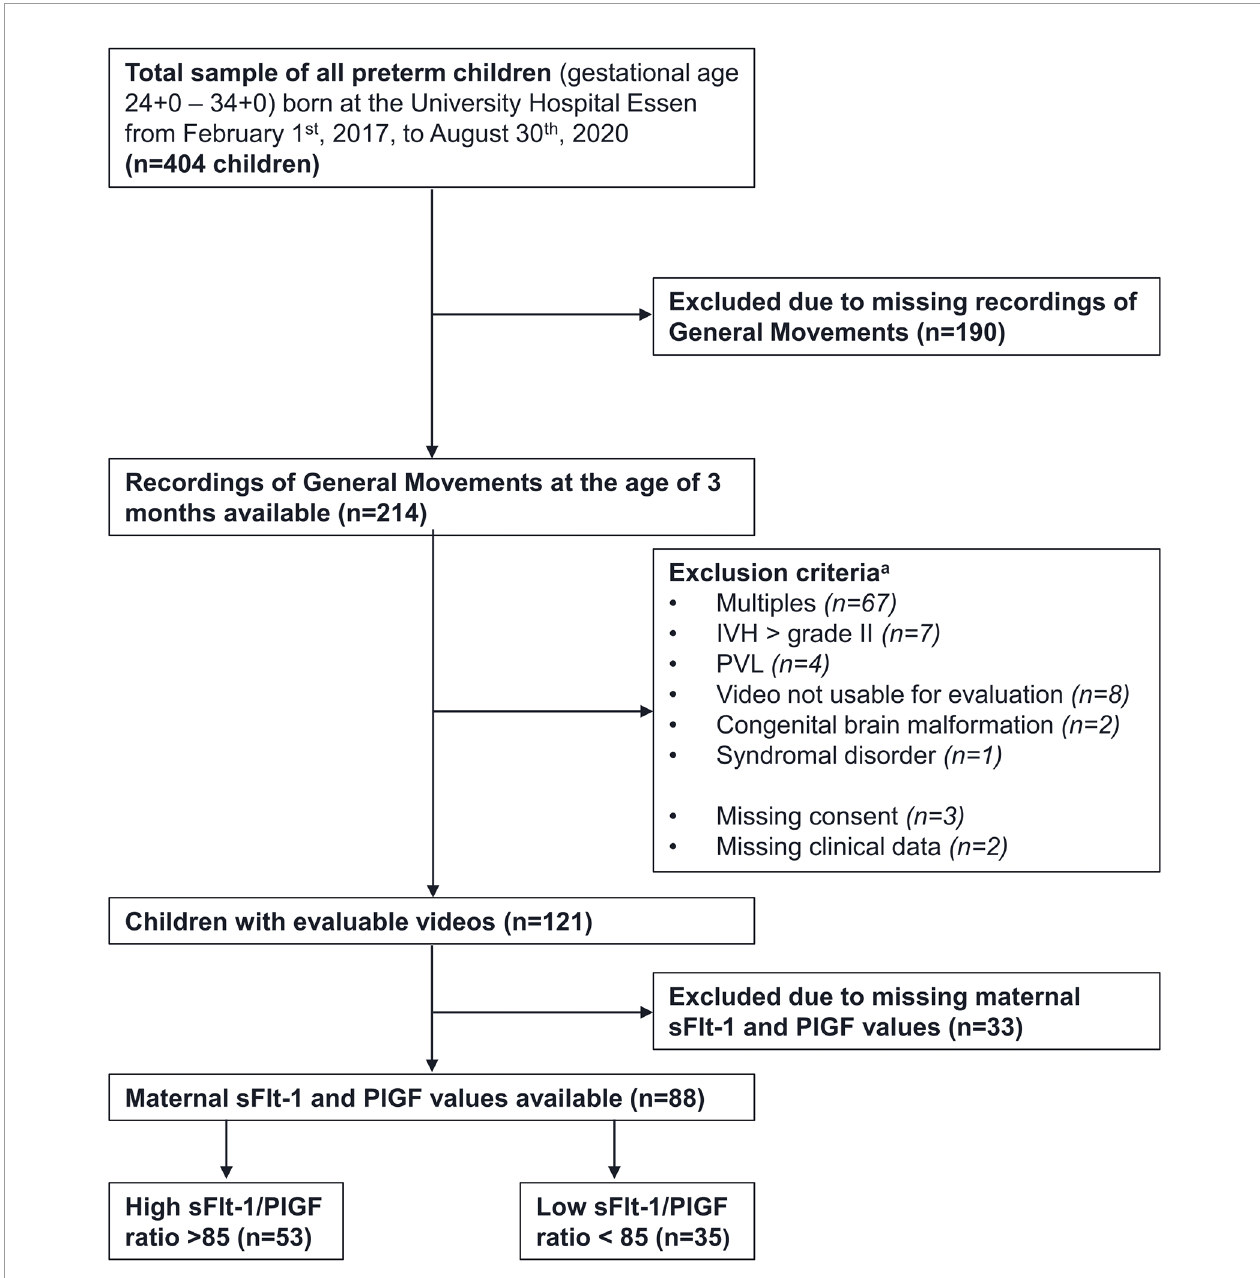
FIGURE 1 | Recruitment strategy and exclusion criteria. Notes. IVH= intraventricular hemorrhage, PVL= periventricular leukomalacia, a participants can ful fi ll multiple exclusion